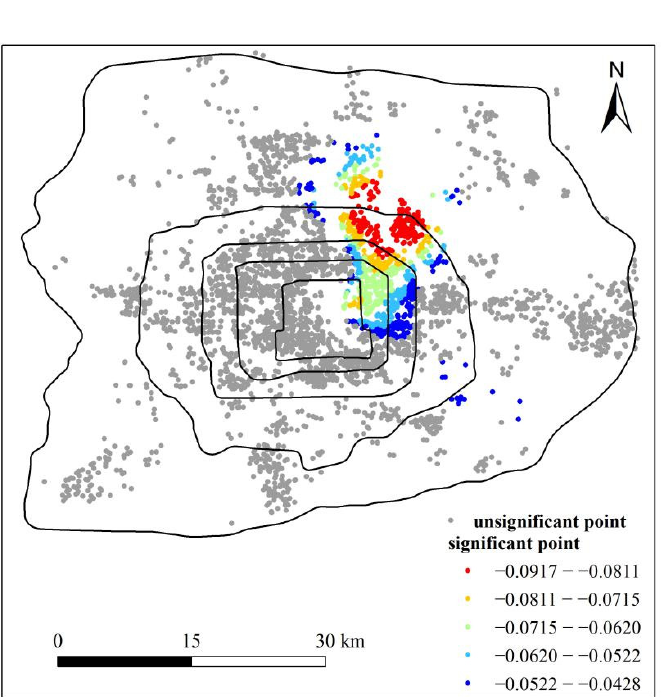
Figure 9. Spatial distribution of regression coefficients of NUMBER1 in Model 1.